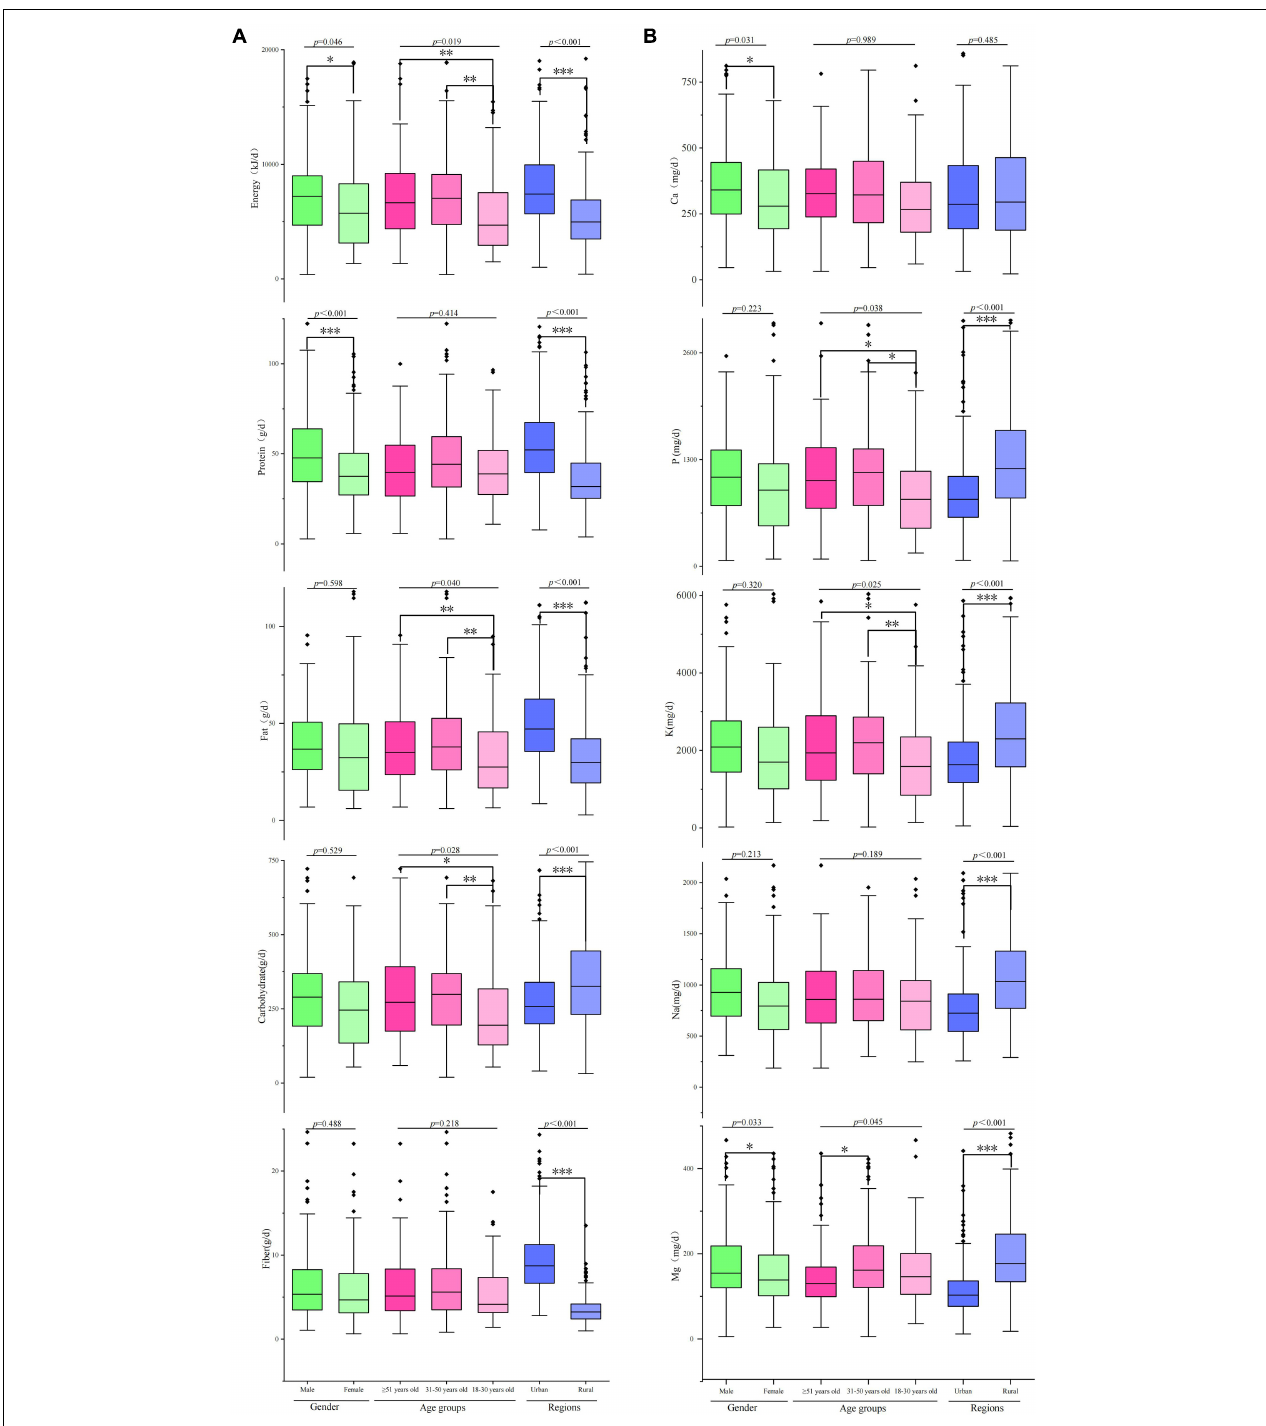
FIGURE 2 | Dietary energy and macronutrient (carbohydrate, protein, fat, and fiber) and mineral (Ca, P, K, Na, and Mg) intakes of Tibetan adults living in agricultural counties of T.A.R. ∗ p < 0.05; ∗∗ p < 0.01; ∗∗∗ p < 0.001.